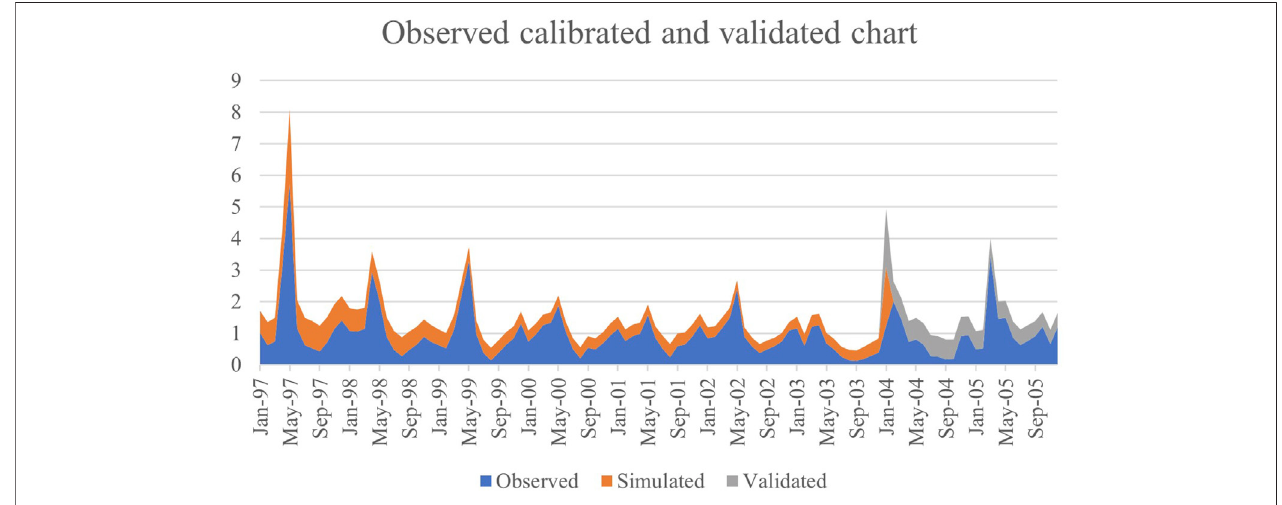
FIGURE 2 | Calibration and validation